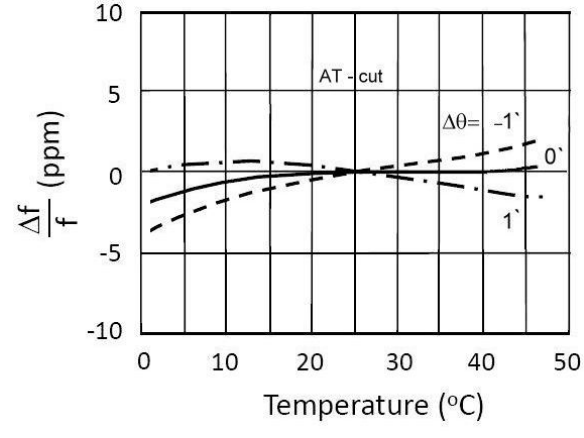
Figure 2. AT-cut quartz crystal temperature characteristics [12].